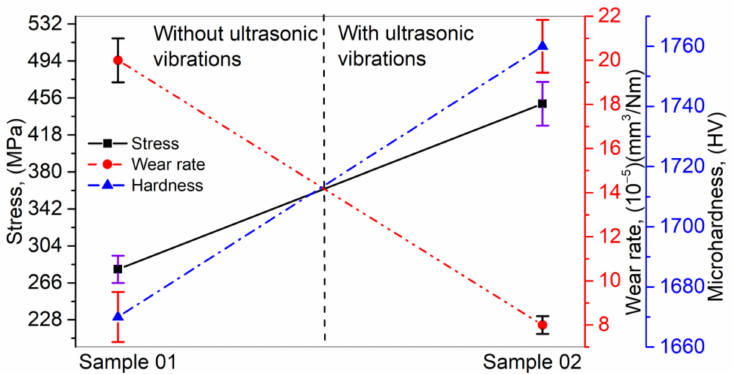
Figure 8. Stress, wear rate, and microhardness of the deposited ZrO 2 + Al 2 O 3 coatings on titanium substrate: with and without ultrasonic vibrations; based on the data from [2].